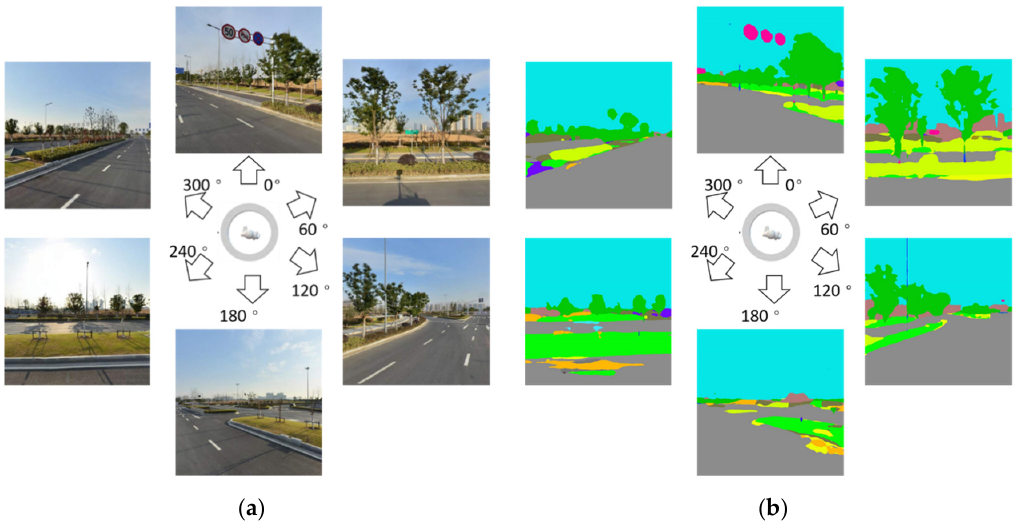
Figure 3. Acquiring street view images in six directions. ( a ) Original street view images from six directions. ( b ) Segmentation results of street view images.